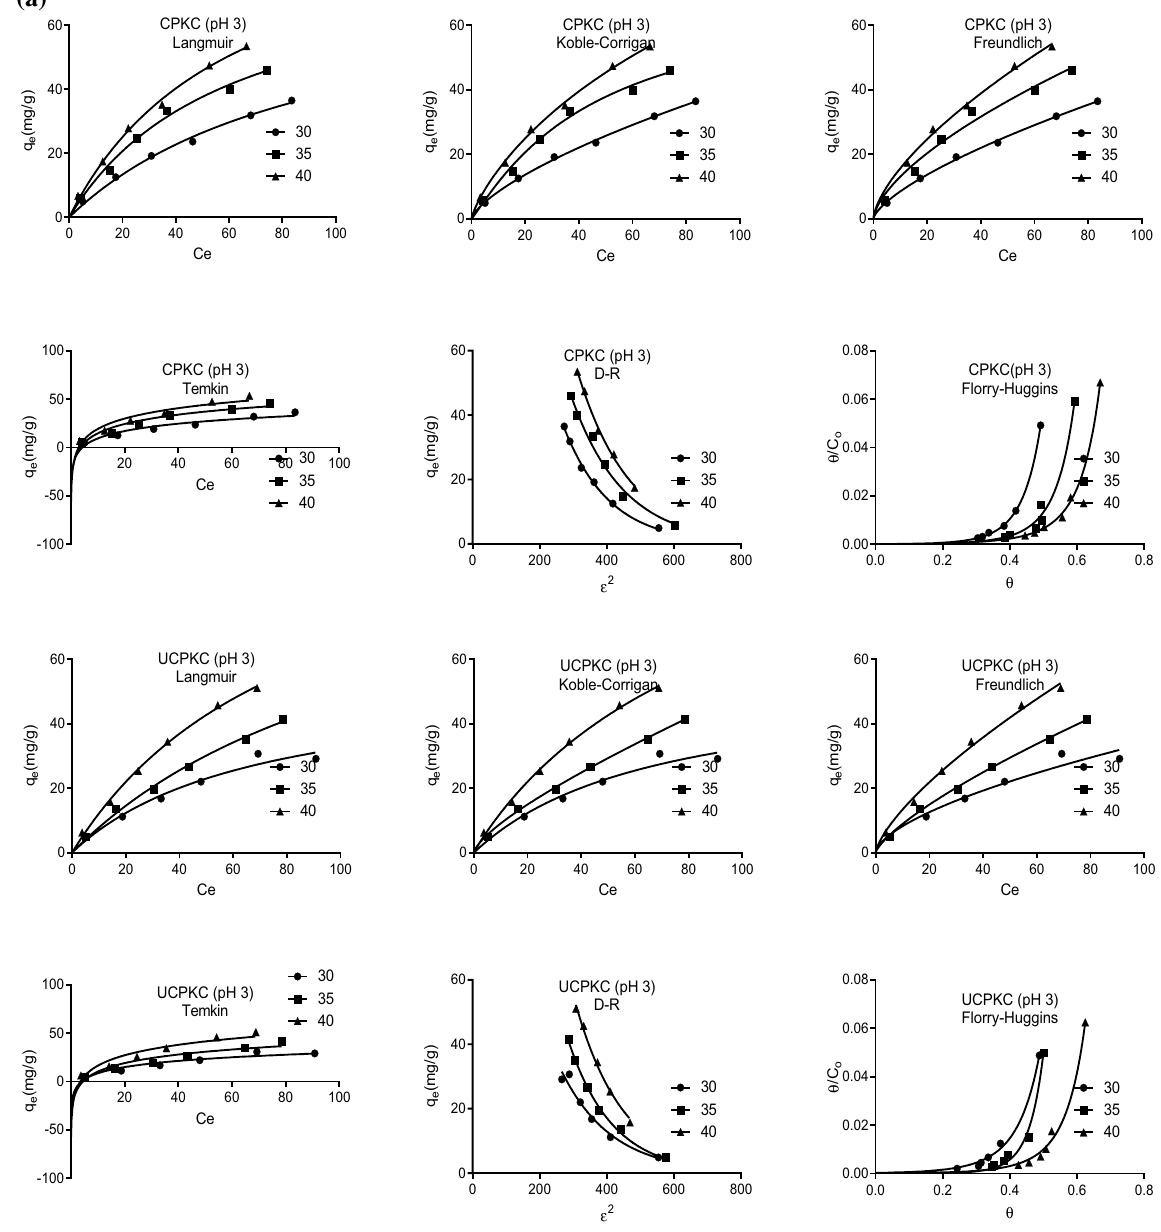
Figure 3. ( a ) Plots of fits of equilibrium data to isotherms at pH 3 and different temperatures. ( b ) Plots of fits of equilibrium data to isotherms at pH 9 and different